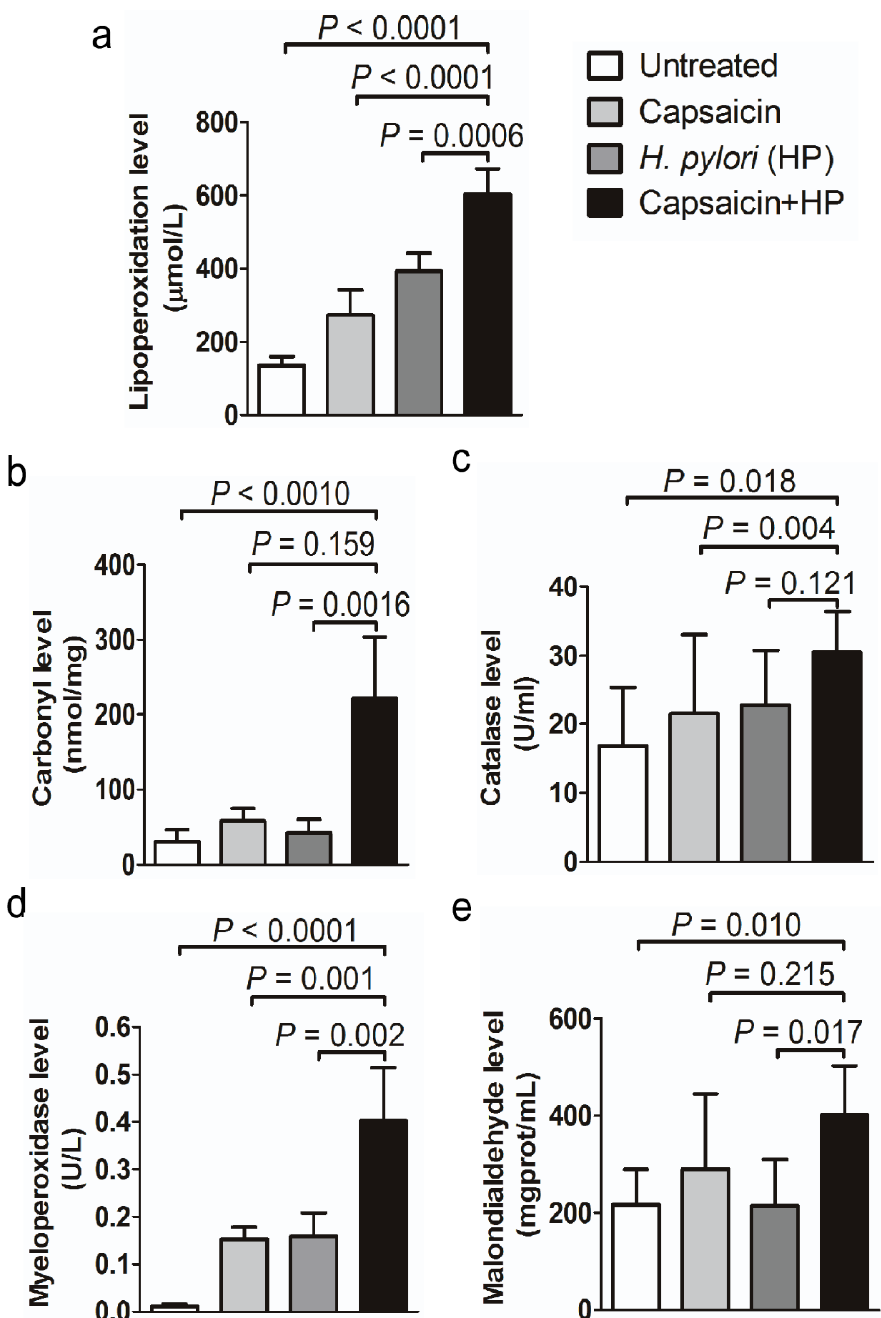
Figure 3. The level of tissue damage in gastric mucosa from gastric disease mouse models. Biochemical activity of ( a ) lipoperoxidase (LPO), ( b ) carbonyl, ( c ) catalase, ( d ) myeloperoxidases (MPO), and ( e ) malondialdehyde (MDA) in mice. Mice exhibiting gastritis or tumorigenesis show higher biochemical activity of these parameters compared to mice treated with capsaicin or H. pylori only ( n = 5/cohort).